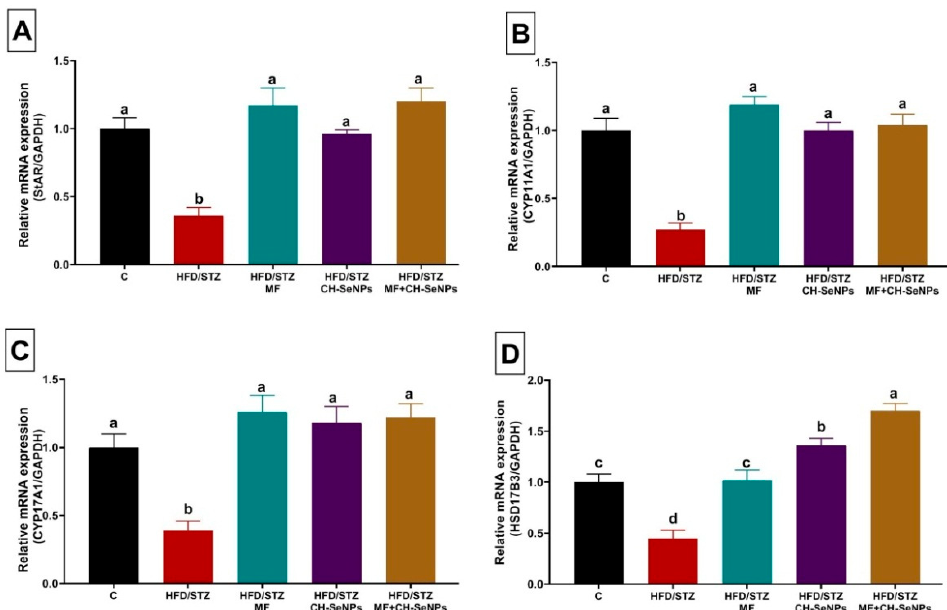
Figure 4. Effect of metformin (MF) and/or chitosan stabilized nanoparticles (CH-SeNPs) oral dos- ing for 60 days on mRNA expression of ( A ) steroidogenic acute regulatory protein (StAr), ( B ) cy- tochrome11A1 (CYP11A1), ( C ) cytochrome17A1 (CYP17A1) and ( D ) hydroxysteroid 17-beta de- hydrogenase 3 (HSD17B3) in the testicular tissues of HFD/STZ diabetic male rats. Data are ex- pressed as mean ± SE, n = 15 for each group. Each bar carrying different letters (a, b, c, and d) was significantly different at p < 0.05.